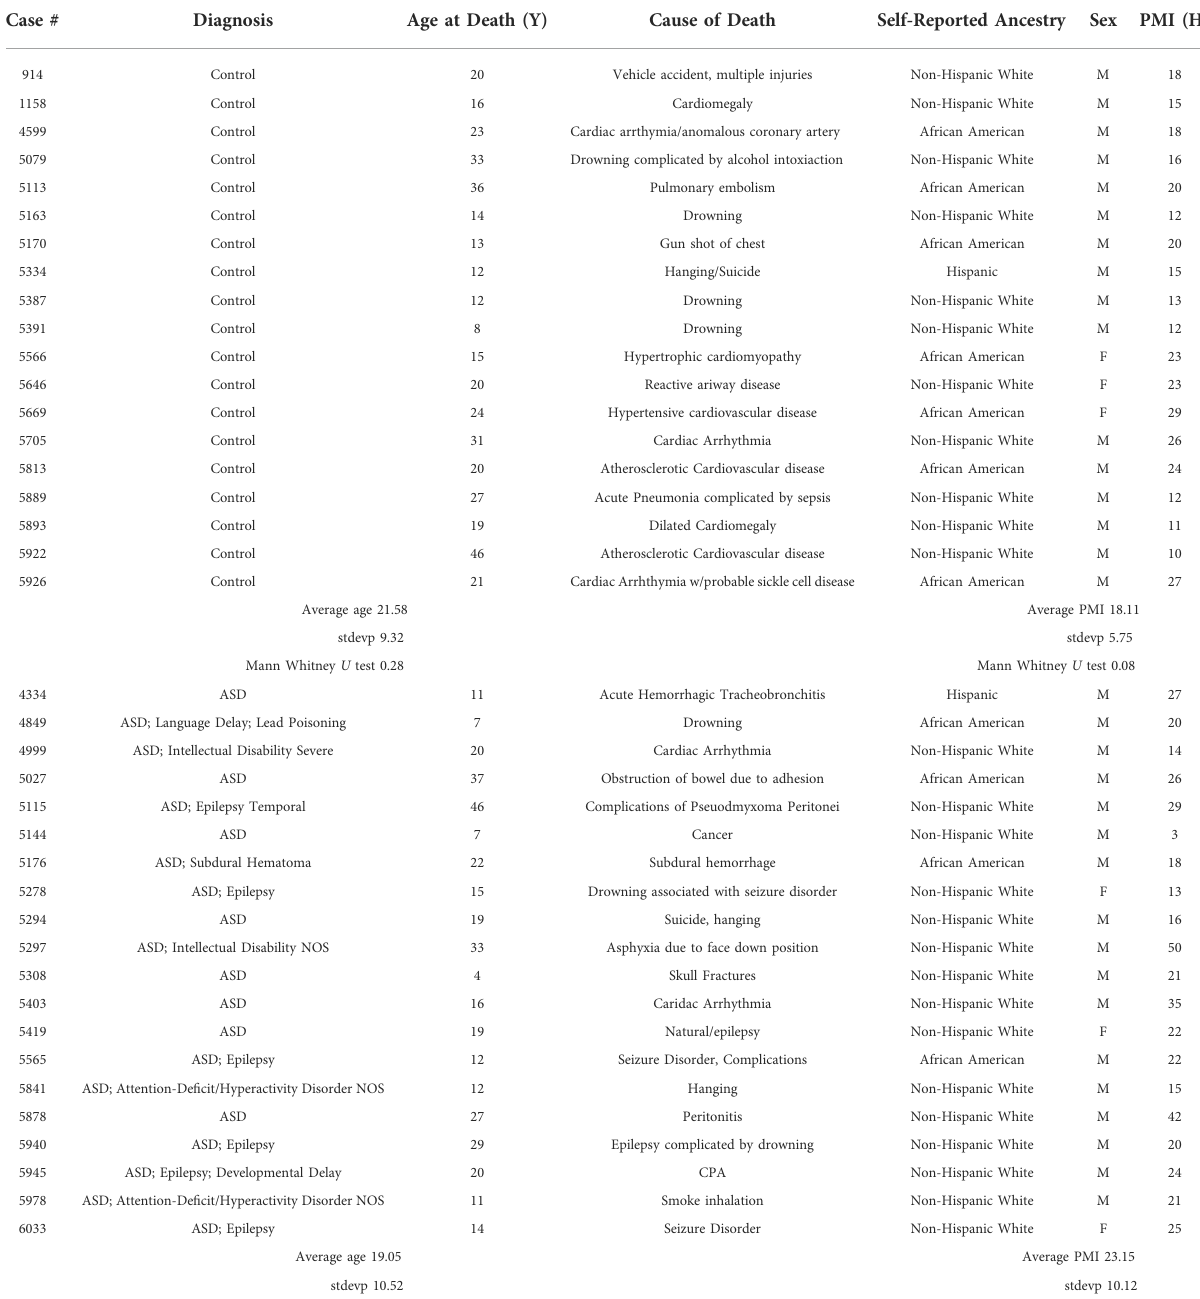
TABLE 1 Postmortem case